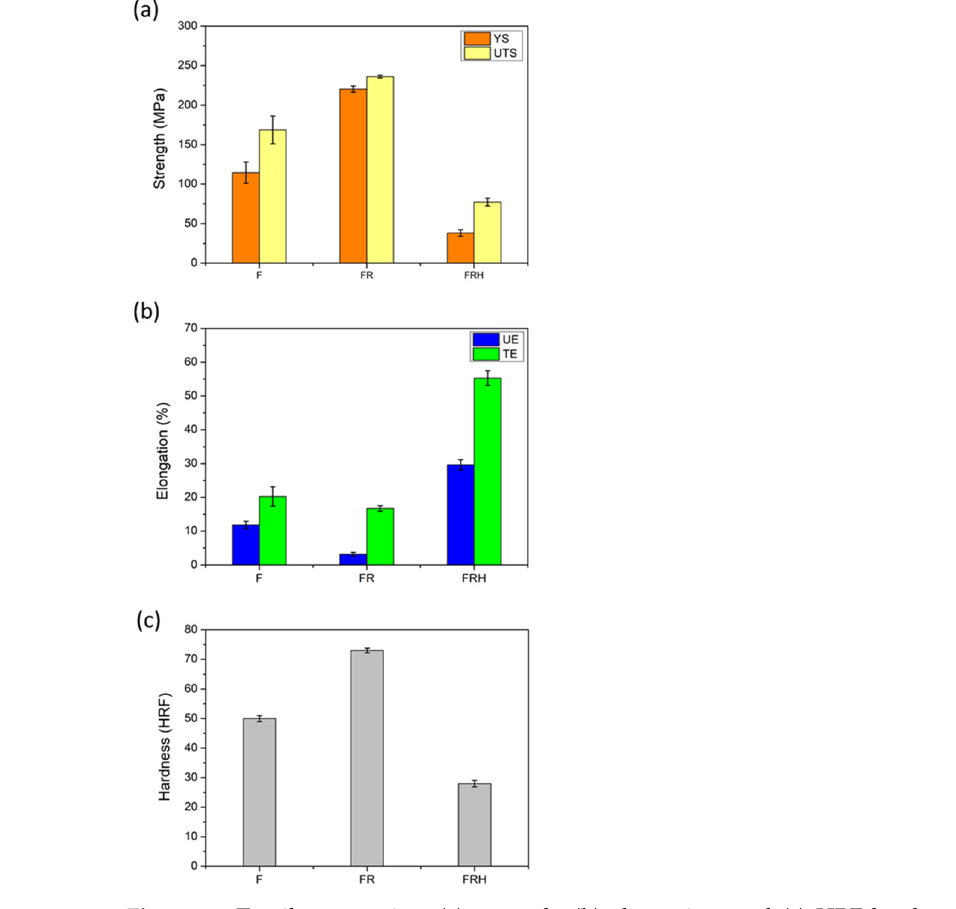
Figure 5. Tensile properties: ( a ) strength, ( b ) elongation, and ( c ) HRF hardness of the CCDR Al–Si alloy.